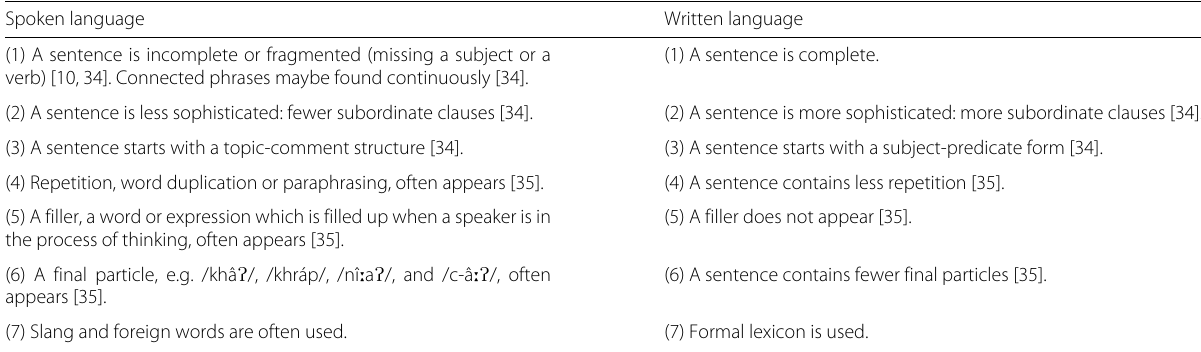
Table 1 Characteristics of Thai spoken language vs. written language Spoken